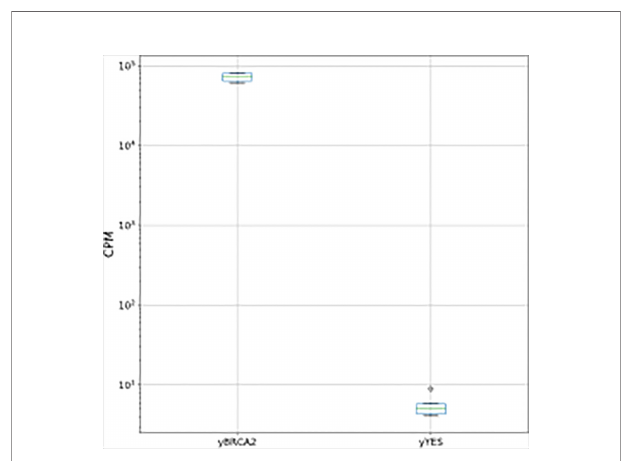
FIGURE 1 | BCA2 normalized counts per million (CPM) for pairwise comparisons between Y- BRCA2 and Y-pYES.